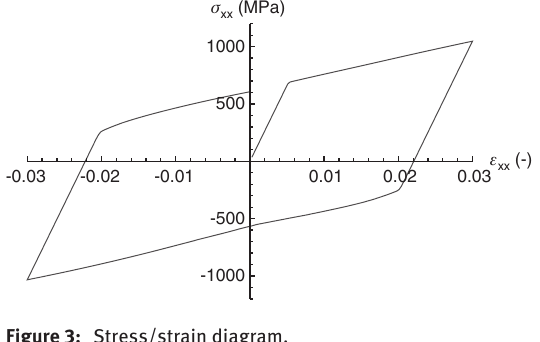
Figure 3: Stress/strain diagram.